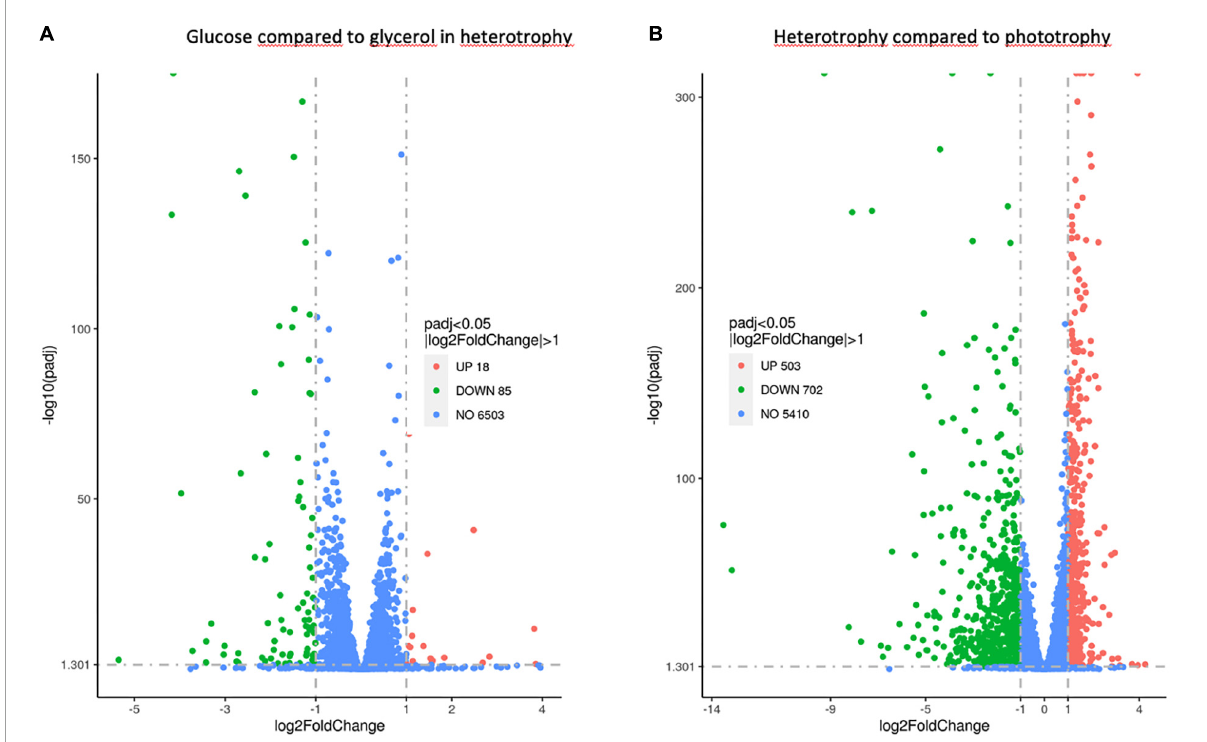
FIGURE5 Vulcano plot of the RNA-seq results. Differential expression analysis of Galdieria sulphuraria genes when grown in heterotrophy in the presence of glucose compared to glycerol (A) and in heterotrophy (glucose and glycerol) compared to phototrophy (B) RNA-seq data sets. Red and green points mark the genes that are up or down regulated, respectively ( p adj < 0.05 and |log2FoldChange| > 1) while blue points mark not differentially expressed genes ( n = 3). The x-axis shows log2FoldChange in gene expression and the y-axis shows the –log10 ajust p .value. P threshold in reported as horizontal gray dashed line